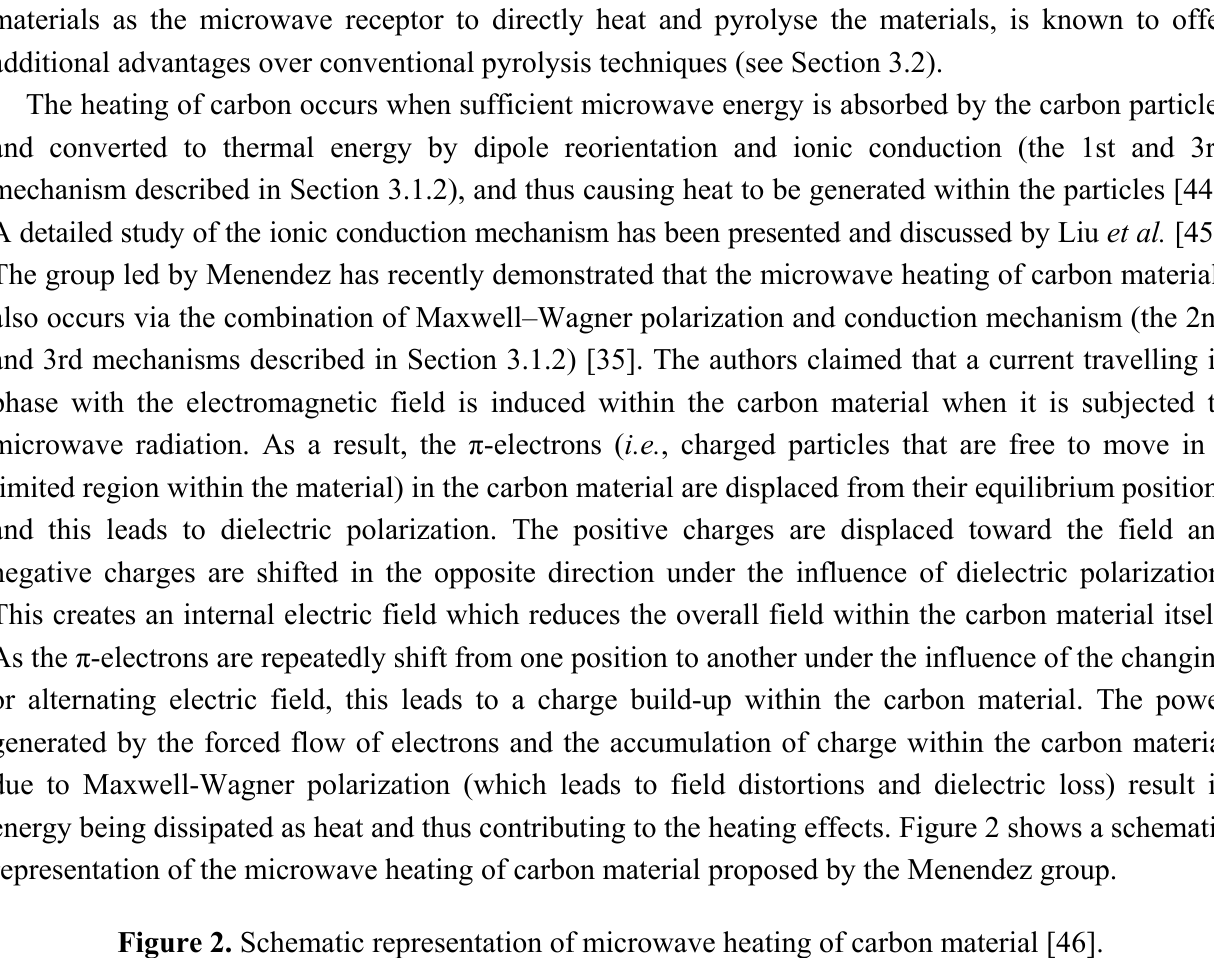
Figure 2. Schematic representation of microwave heating of carbon material